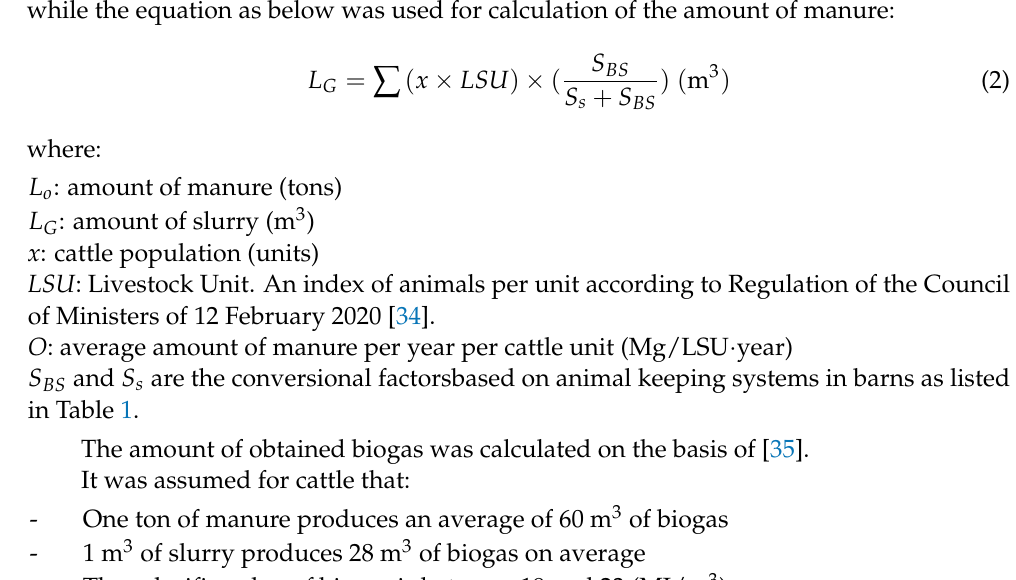
Table 1. The conversial factors S BS and S s based on Central Statistical Office of the 2010 Agricultural Census [33]. Animal Keeping System Voivodeship Stands with a Slatted Floor ( S BS ) Stands with a Solid Floor ( S s ) Mazowieckie 0.149 0.851 Podlaskie 0.770 0.230 Wielkopolskie 0.343